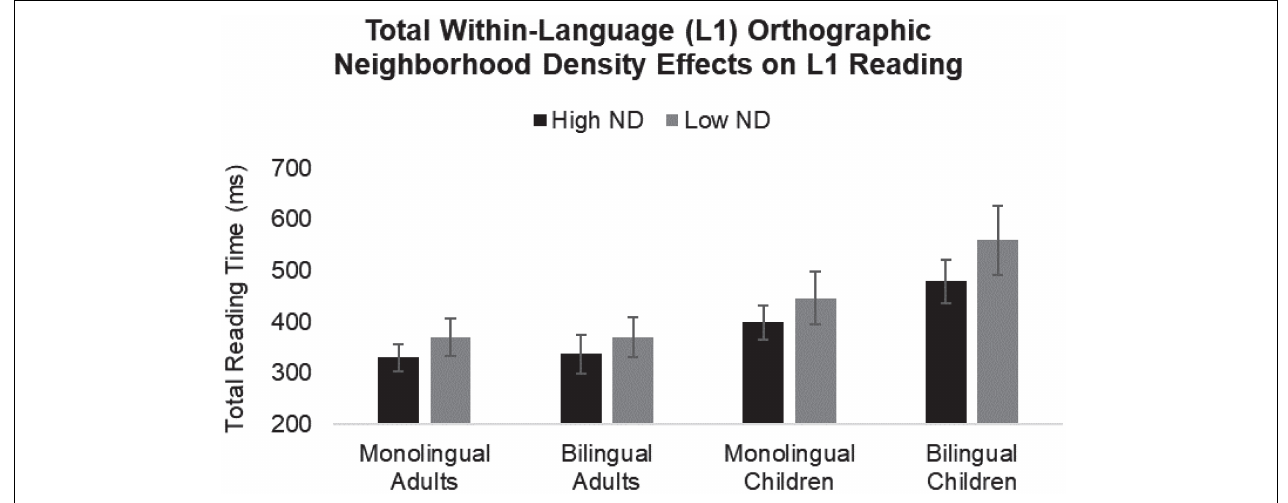
FIGURE 1 | The effect of total within-language (L1) orthographic neighborhood density on the monolingual and bilingual age groups’ L1 total reading times. Means are plotted. Error bars represent ± 1 standard error of the mean.